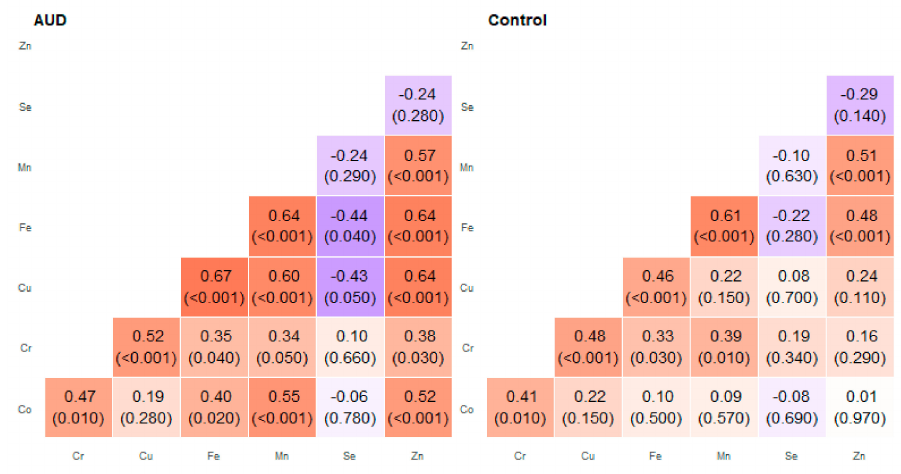
Figure 10. Correlation matrix of Spearman coe ffi cient charts in the frontal cortex region in the alcohol use disorder and control